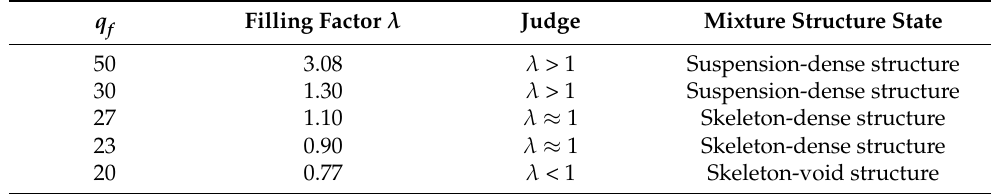
Table 2. Application of λ to determine the structure type of phosphorus tailing–graded waste rock mixture.